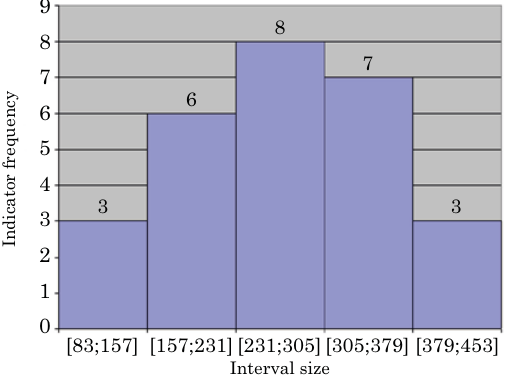
fig. 3. Histogram of the importance of the premises